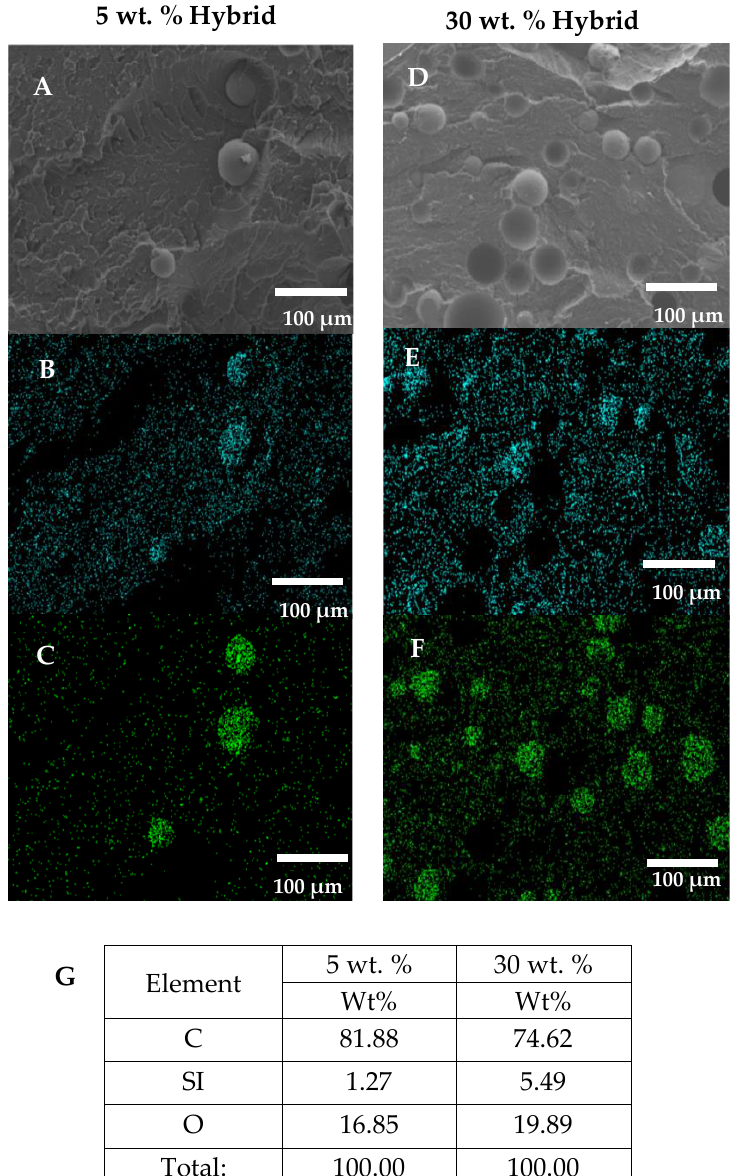
Figure 2. FESEM and EDX analysis of hybrid composites for 5 wt.% ( A – C ) and 30 wt.% ( D – F ). Figure ( B , E ) is showing EDX mapping analysis for silicon for both loadings. Figure ( C , F ) is showing EDX mapping analysis for oxygen for both loadings. Weight percent measurement which is obtained from the EDX analysis ( G